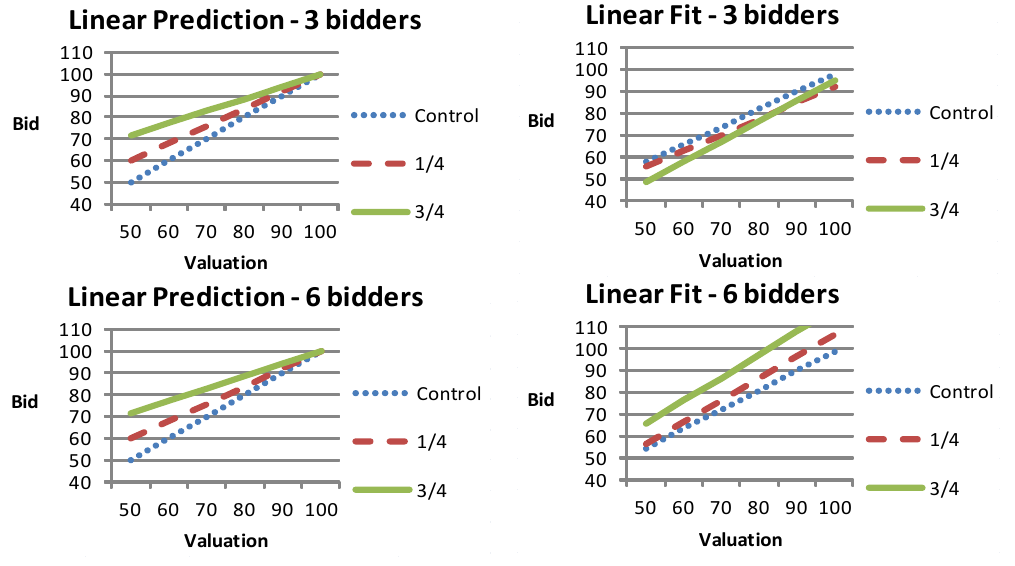
Figure 1. SPSB conditions. Theory and linear fit of the bid data on